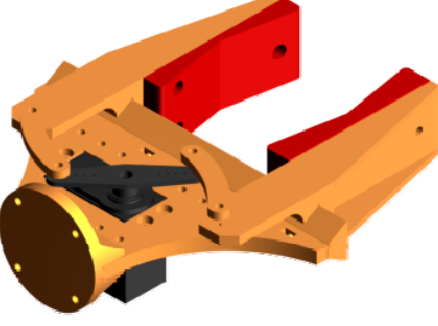
Figure 3. The two-fingered gripper.